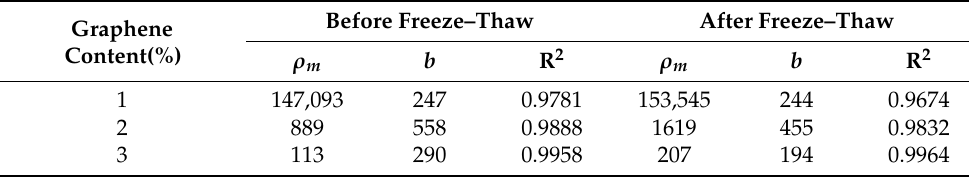
Table 9. Fitted results of electrical resistivity of specimens incorporating different graphene contents before and after